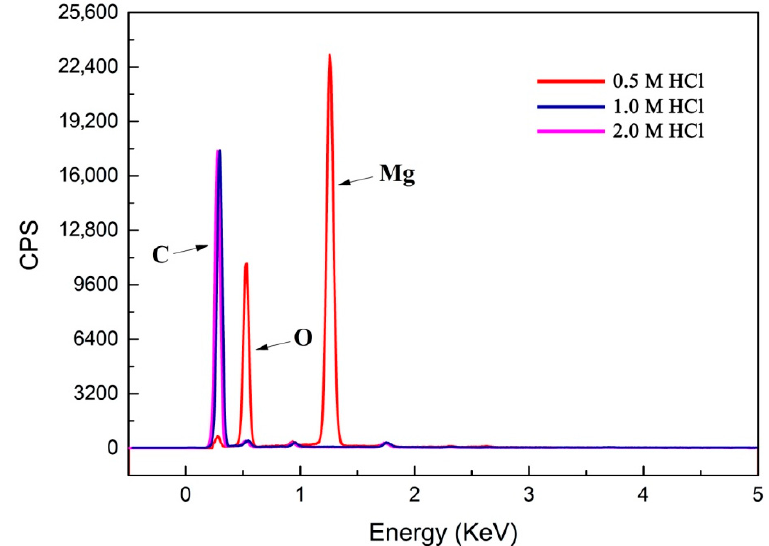
Figure 8. X-ray spectroscopy (EDS) spectra of multilayered graphene sheets treated with different concentrations of HCl (0.5 M, 1.0 M, and 2.0 M). EDS spectra of multilayered graphene sheets treated with 0.5 M HCl, 3.21 (norm wt%) C, 56.52 (norm wt%) Mg, 40.27 (norm wt%) O; EDS spectra of multilayered graphene sheets treated with 1.0 M HCl, 98.61 (norm wt%) C, 0.01 (norm wt%) Mg, 1.38 (norm wt%) O; EDS spectra of multilayered graphene sheets treated with 2.0 M of HCl, 98.58 (norm wt%) C, 0.01 (norm wt%) Mg, and 1.41 (norm wt%) O.